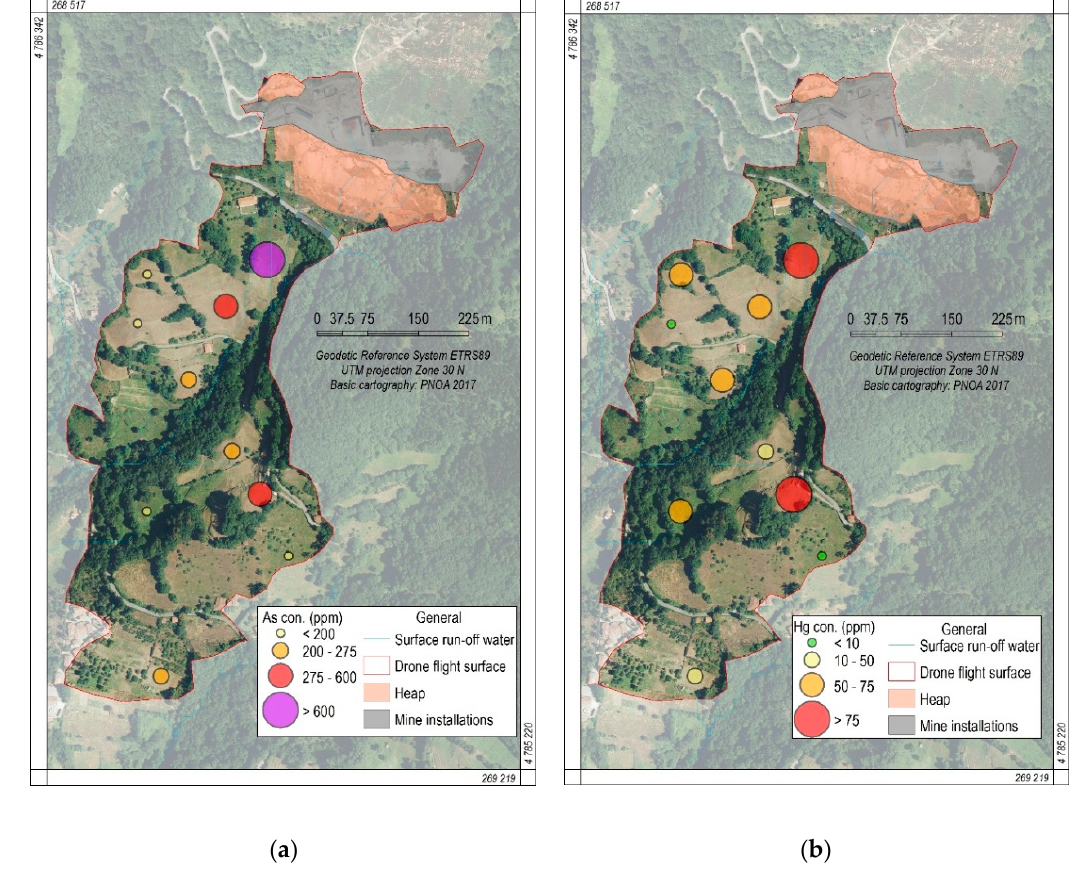
Figure 3. Concentrations of: ( a ) As and ( b ) Hg, in the study area.